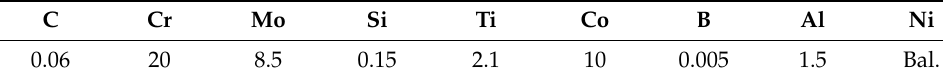
Table 1. The nominal composition in wt.% of Haynes 282.